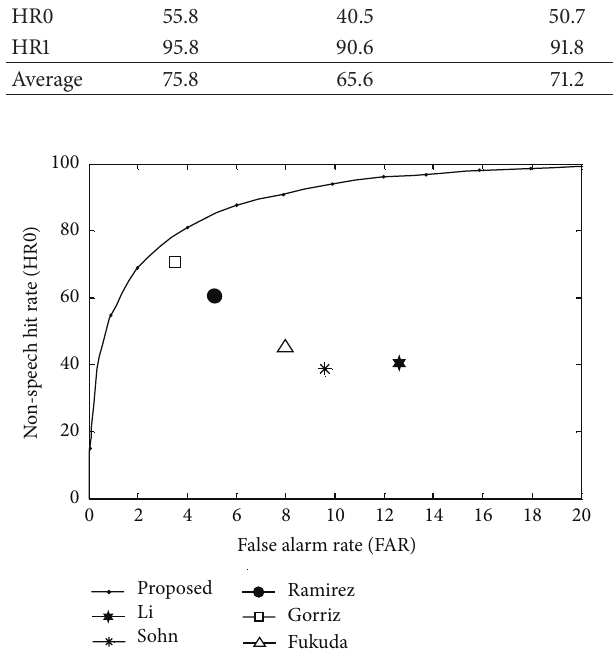
Figure 12: ROC curves: environment of high speed driving on highway (SNR − 8dB, 70–90 km/h).